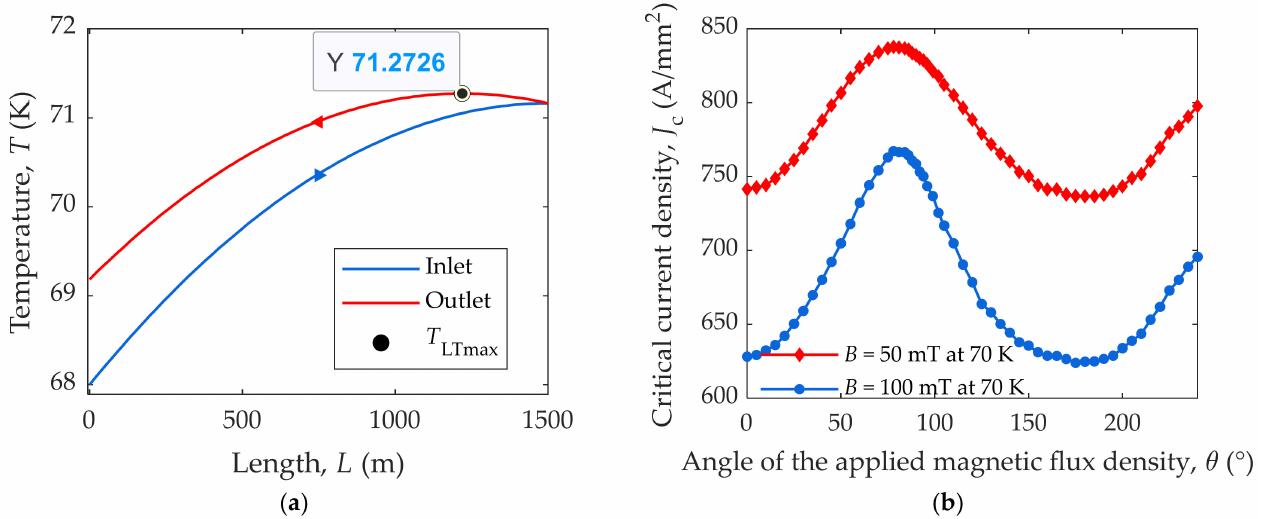
Figure 9. ( a ) Temperature of the two liquid nitrogen pipes as a function of length; ( b ) dependence of the critical engineering current density of a 2G-HTS tape on the magnetic flux density and its application